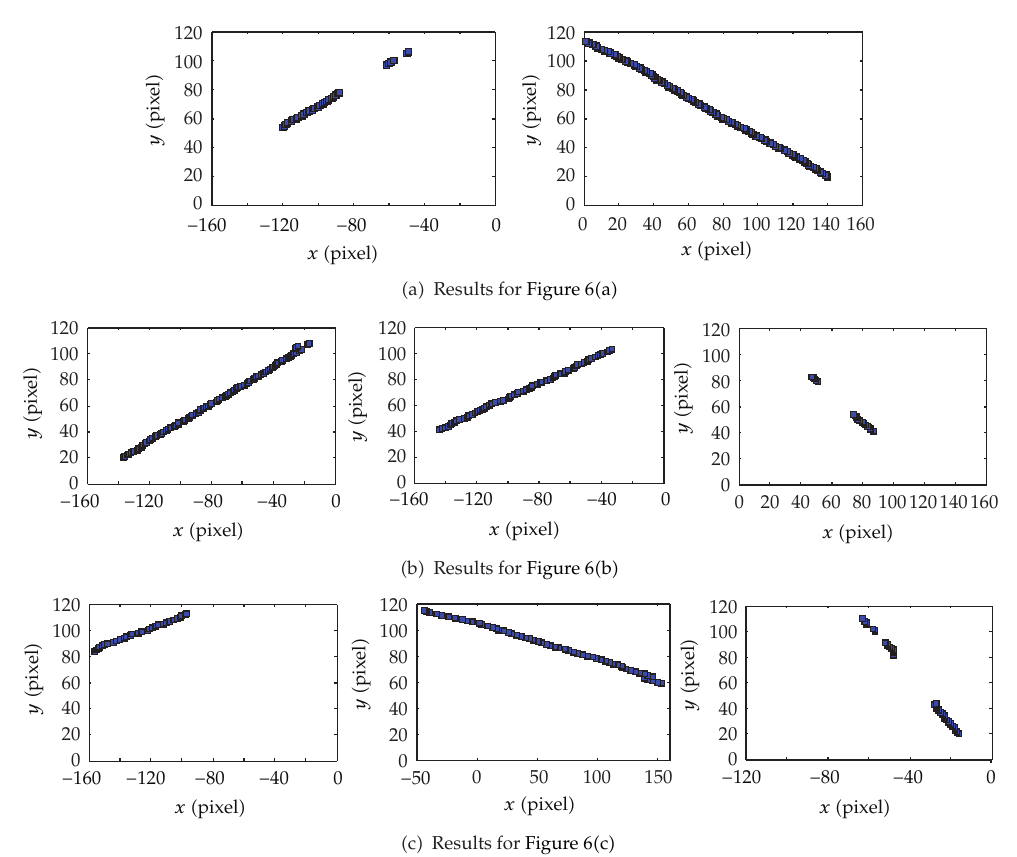
Figure 7: Seed points classification results for images in Figure